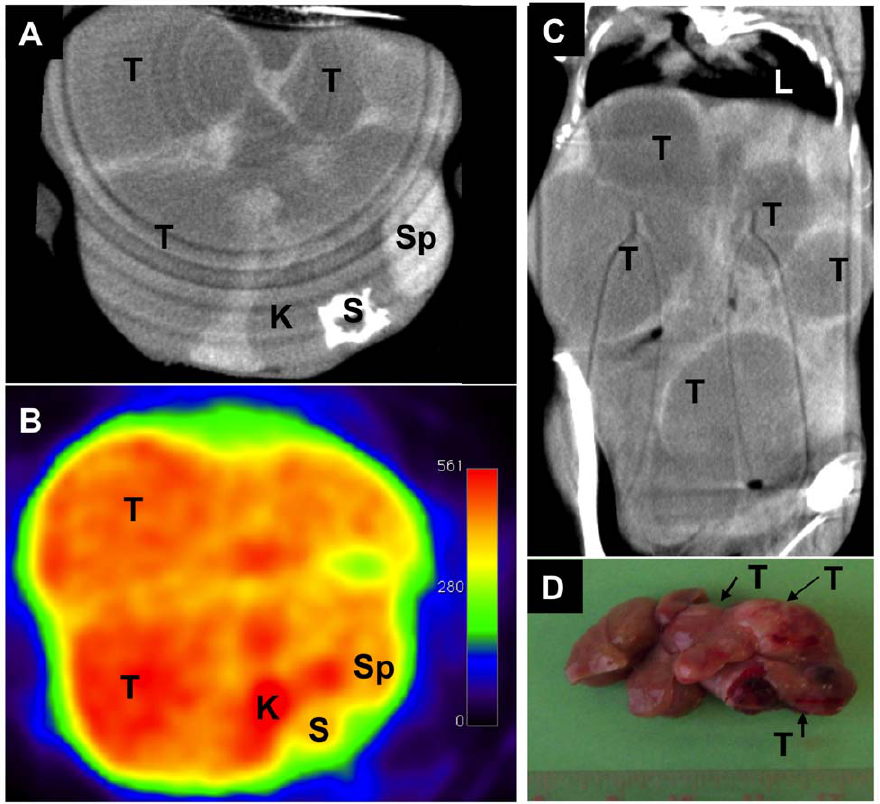
Figure 1. Contrast-enhanced CT and 18 F-FDG-PET of the liver of an NDEA-treated c-Myc transgenic mouse. Axial slices of a CT (A) and an FDG-PET scan (B) as well as coronal slices of a CT scan (C) and macroscopic view (D) of an explanted liver of an NDEA treated mouse at the age of 7 months. When compared to the normal liver parenchyma tumors are hypodens at CT as the uptake of the liver specific contrast agent is reduced. PET scans reveal tumor lesions by an increased tracer uptake due to enhanced glucose metabolism. Because of the advanced stage of disease tumors of different size had merged together. K=kidney, L=lung, S=spine, Sp=spleen, T=tumor.